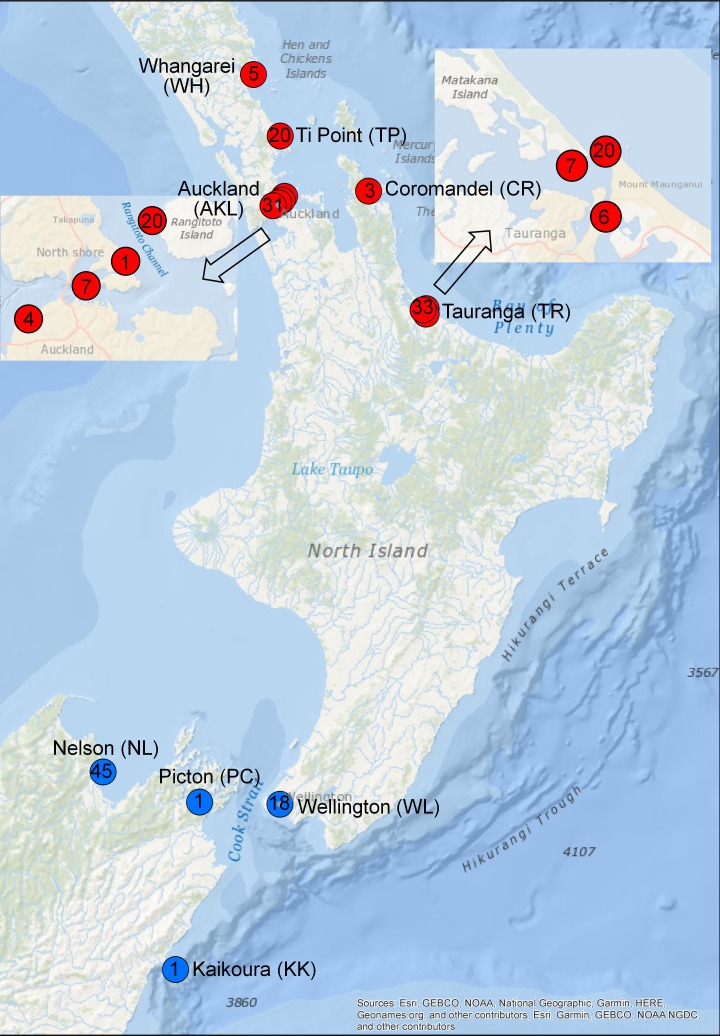
Sampling locations for the Pleurobranchaea maculata individuals.The numbers within the circles indicate the sampling size of each region. The arrows show magnified maps of Auckland and Tauranga. Populations containing P. maculata individuals with high, and low and trace amounts of tetrodotoxin concentrations in red and blue colour, respectively.